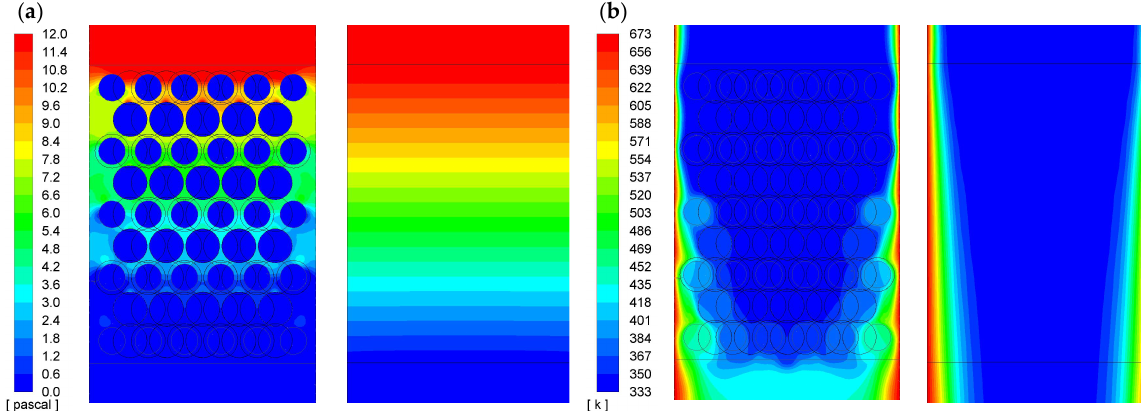
Figure 10. Comparison of the pressure ( a ) and temperature ( b ) distribution within the bed for the full and simplified model (an example of a 13-layer bed with 3-mm diameter spheres).